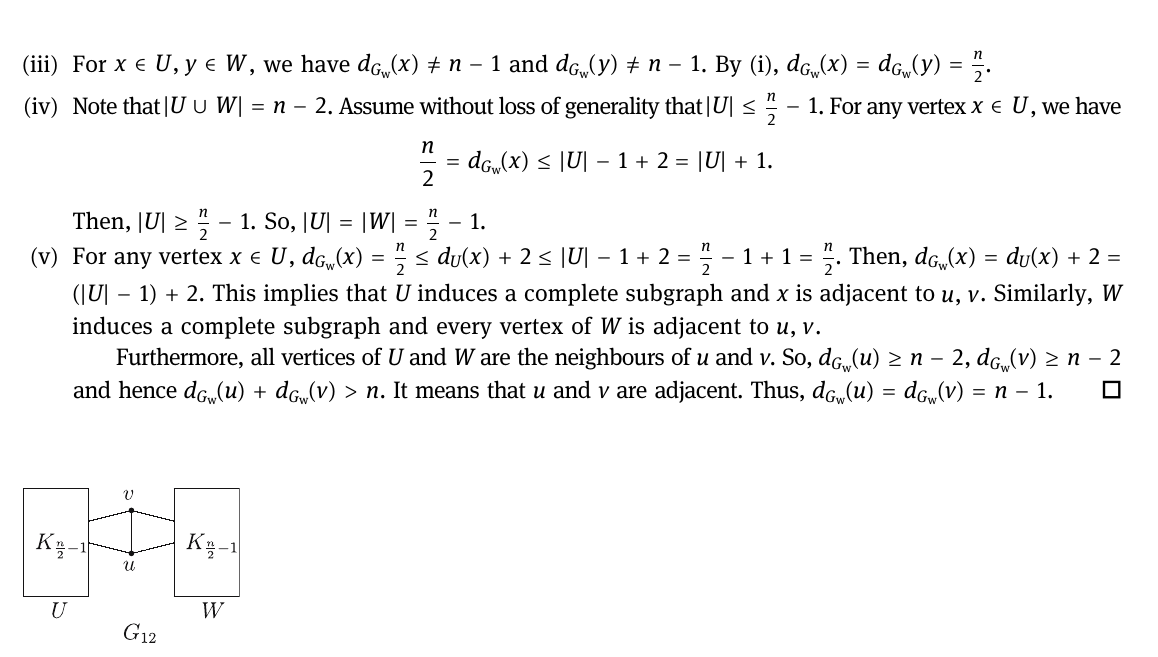
∈ G φ 12 1 ( Figure 4 ) , in which U and W are complete subgraphs with | | = | | = 12